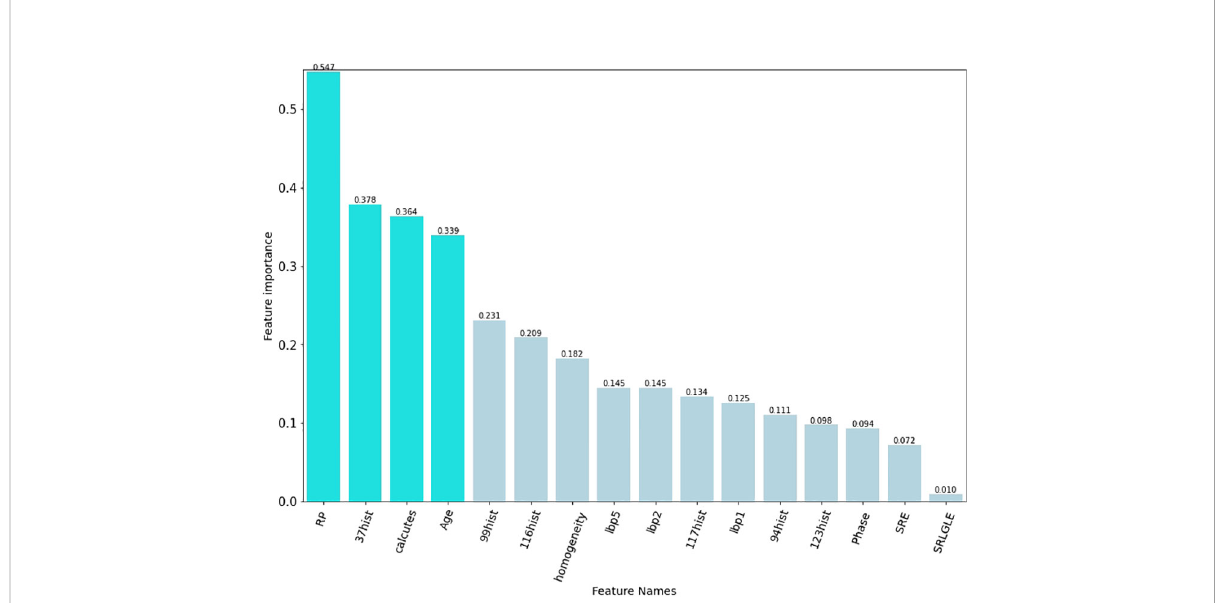
FIGURE 5 The fi nal elements that were chosen to be maintained. The preserved characteristics were on the y axis, and the matching LASSO regression coef fi cients were on the x axis. The log( l ) coef fi cients of the features that have been fi